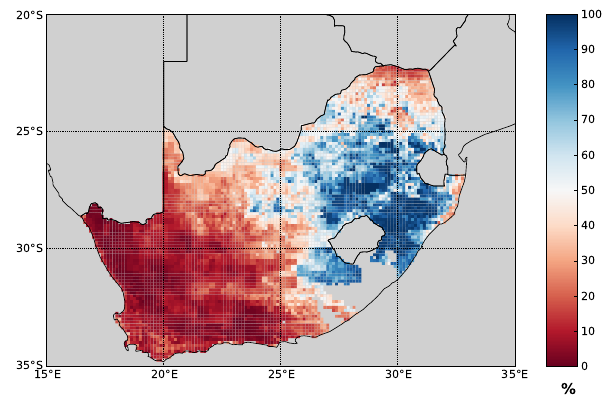
Fig. 9. An example of the country-wide soil moisture estimates produced by TOPKAPI in LSM mode. The colour scale represents the Soil Saturation Index (SSI), the percentage of soil void space filled by water (see Eq. 5). The grey gaps are due to a current lack of suitable soil property